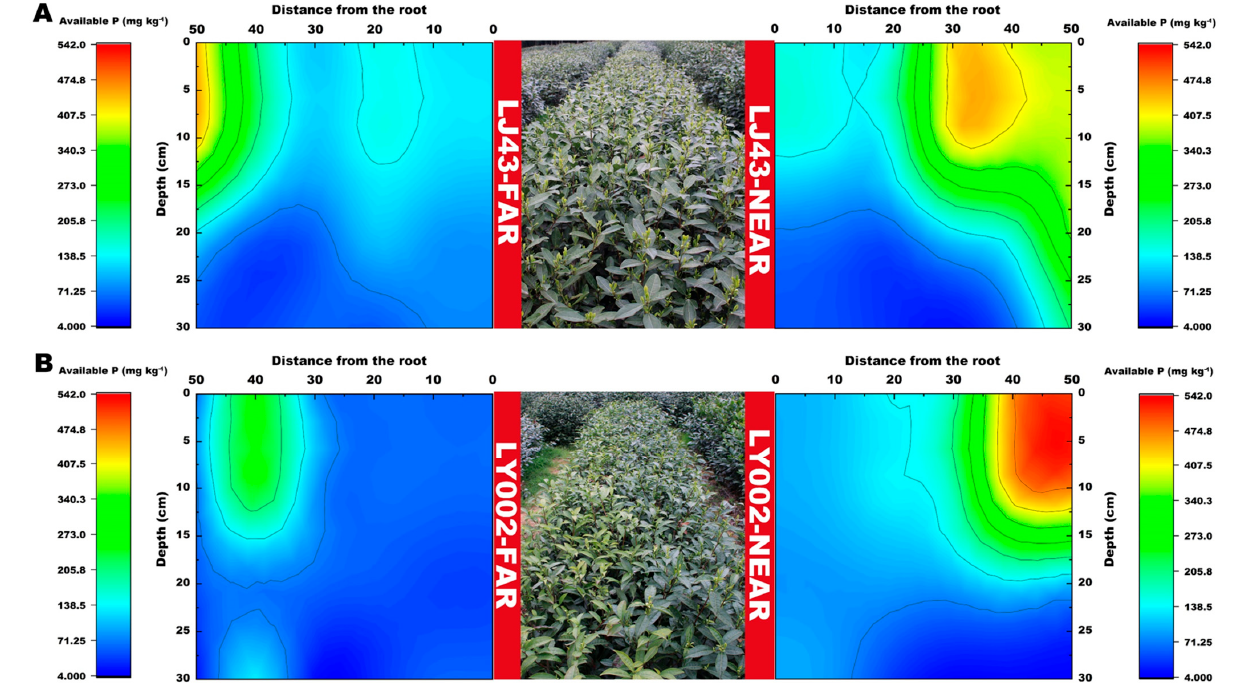
Figure 4. Variation in soil available P content related to LJ43 and LY002 with different treatments. ( A ): LJ43; ( B ): LY002. Data show the mean ± standard deviation ( n = 3). The fertilization zone is located at the right-most side (i.e., 50 cm distance to LJ43-near or LY002-near main roots). Regarding the tea plants near the fertilization belts (LJ43-near or LY002-near), the fertilization belt was 50 cm distance from main roots of the tea plants; regarding the tea plants far from the fertilization belts (LJ43-far or LY002-far), the fertilization belt was 100 cm distance from the main roots of the tea plants.